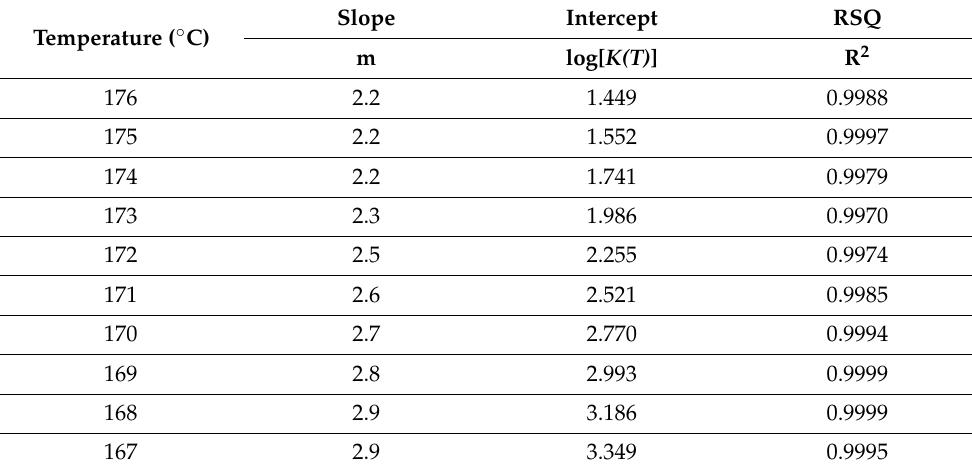
Table 5. Ozawa exponents and cooling functions of